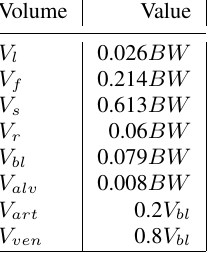
T HE COMPARTMENTAL FLOWS AND PARTITION T HE COMPARTMENTAL VOLUMES USED IN SIMULATIONS COEFFICIENTS USED IN SIMULATIONS OF THE XYLENE OF THE XYLENE PBPK MODEL . A LL VALUES ARE THE PBPK MODEL . SAME AS USED FOR THE “N ON - AGED ADULT ” IN [47] EXCEPT FOR V r , V bl , V alv , V art , AND V ven . V r WAS ALTERED TO HAVE ALL VOLUMES SUM TO 100%. V bl V alv , V art , AND V ven ARE BASED ON